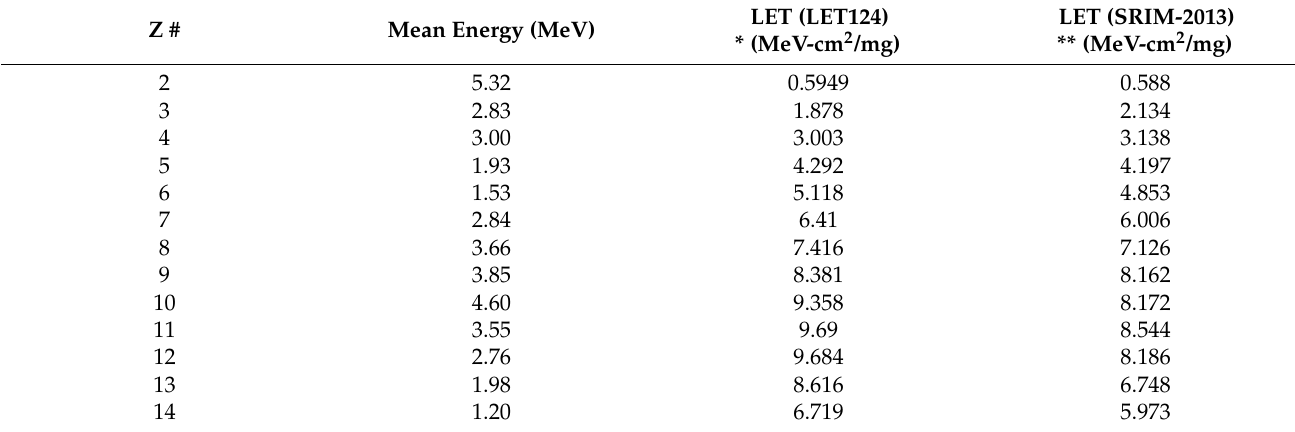
Table 1. The calculated LET using mean energy of secondary particles generated by 200 MeV proton irradiate on